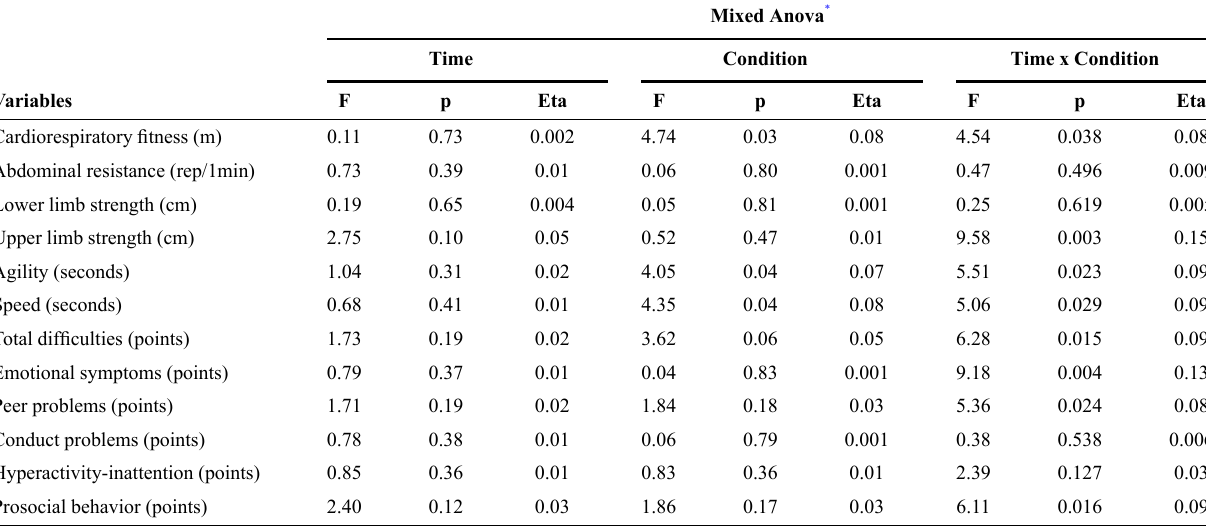
Table 2 - Physical education Programs effect in time, condition and interaction on physical fitness and mental health. Mixed Anova ∗ Time Condition